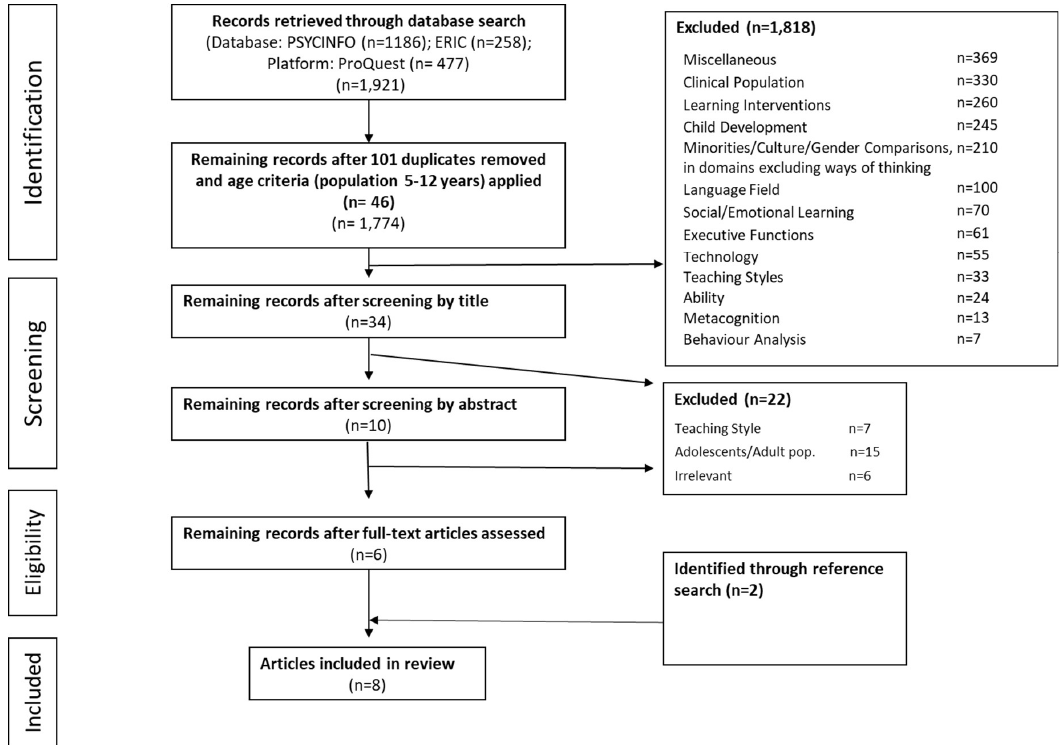
Figure A1. Flow Chart of Study Identification